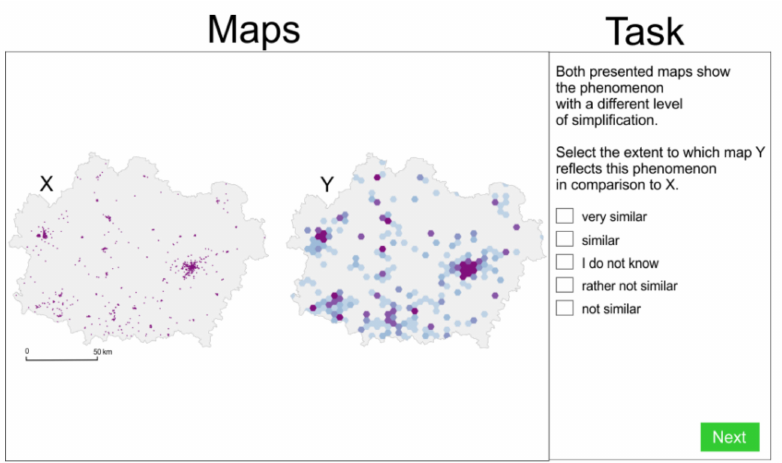
Figure 3. The layout of one particular task in the